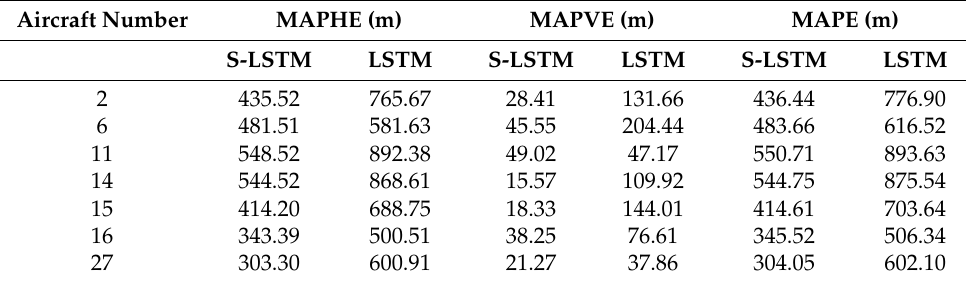
Table 2. Comparison of aircraft prediction errors under the two